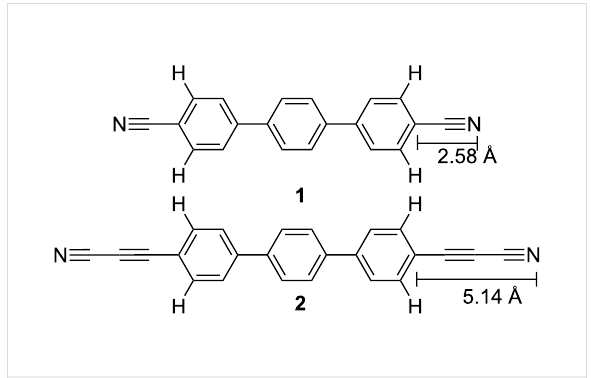
Figure 1: Representation of the structure of the molecular linkers: terphenyl-4,4"-dicarbonitrile ( 1 ) [24,43], terphenyl-4,4"-di(propioloni- trile) ( 2 ) showing the increased distance of the coordinating carbo- nitrile N-donor atom from the sterically hindering α -C–H group at the phenyl